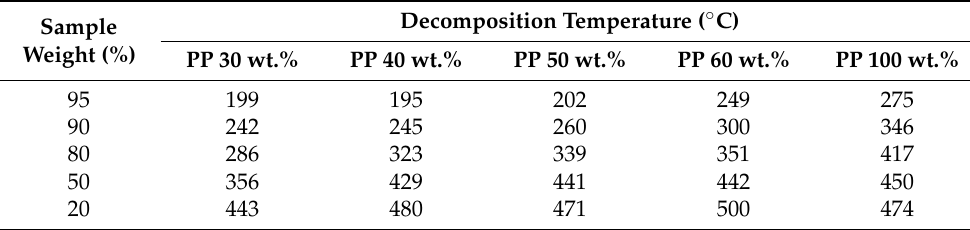
Figure 4. TGA of coconut shell biocomposite for various PP compositions with 200 mesh of coconut shell particles. Table 2. Decomposition temperature of coconut shell biocomposite for various PP